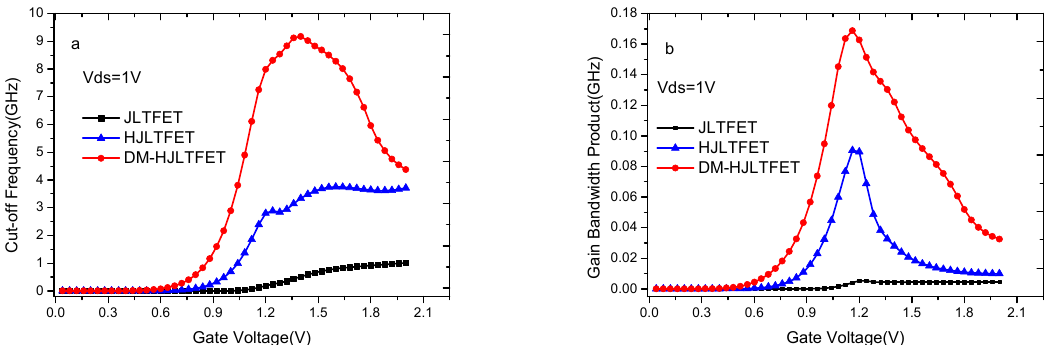
Figure 12. ( a ) The cut-off frequency(f T ) characteristic curves of JLTFET, HJLTFET and DMMG-HJLTFET; ( b ) the gain bandwidth (GBW) characteristic curves of JLTFET, HJLTFET and DMMG-HJLTFET.